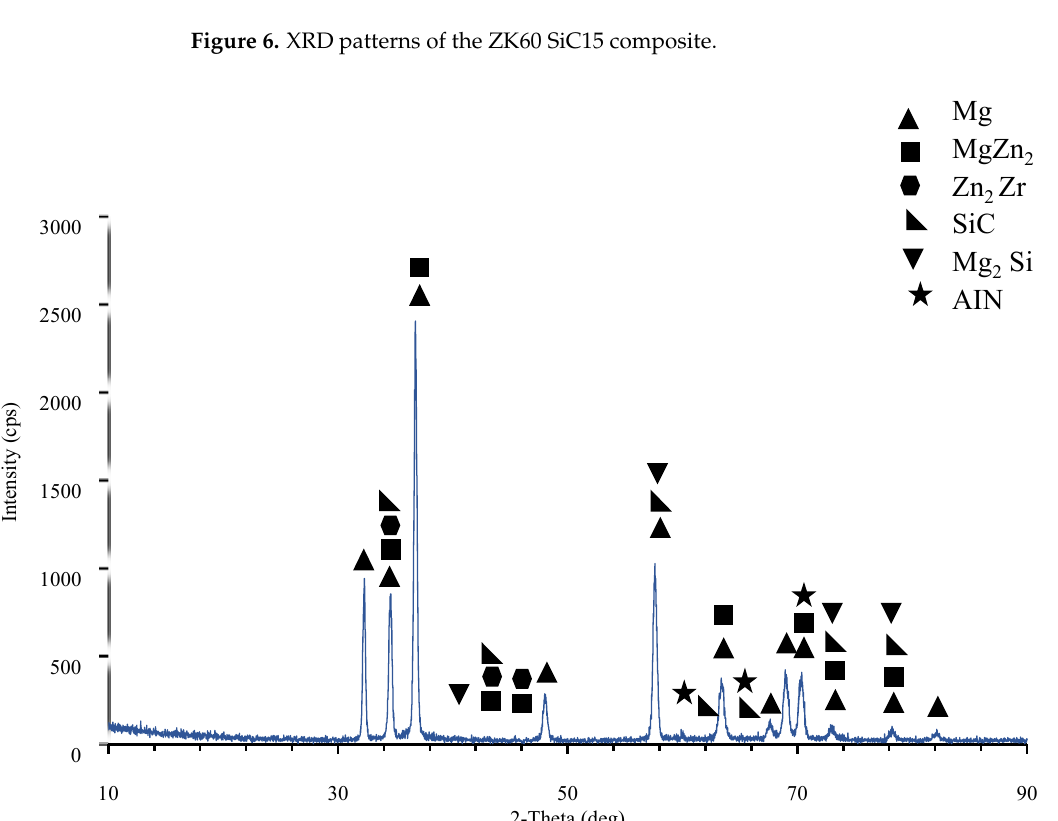
Figure 7. XRD patterns of the ZK60 SiC15 AIN0.2 composite.